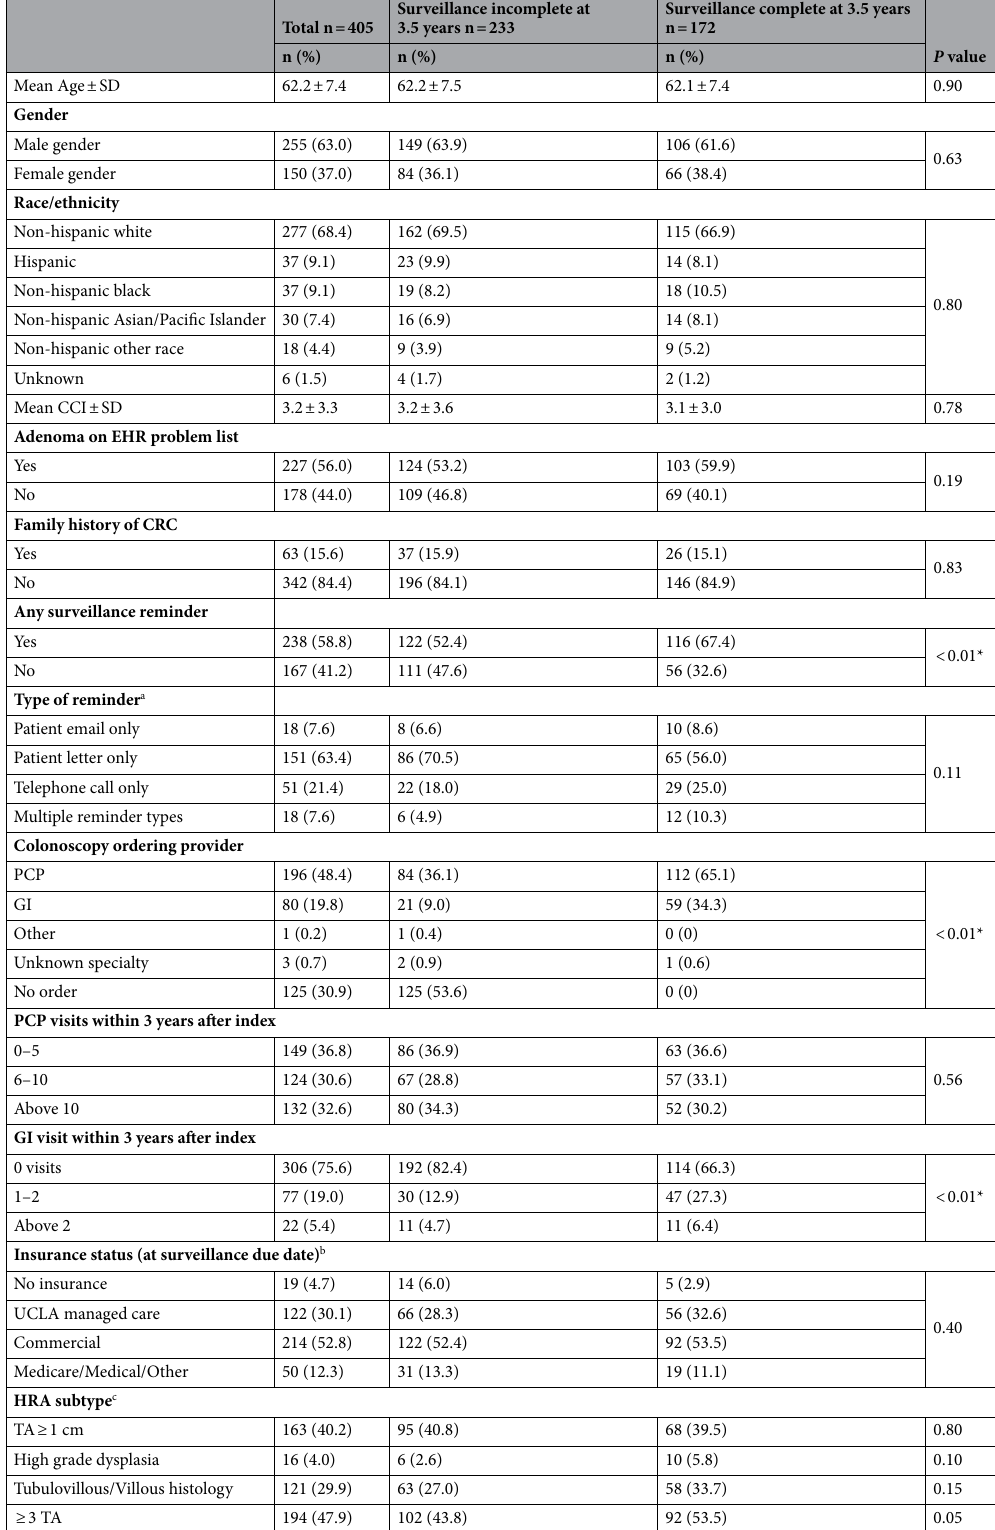
Table 1. Demographic and clinical characteristics for the total patient cohort, overall and by surveillance status at 3.5 years. CCI Charlson Comorbidity Index; CRC colorectal cancer; EHR electronic health record; GI gastroenterologist; HRA high risk adenoma; PCP primary care physician; SD standard deviation; TA tubular adenoma. a Comparing only among those receiving a reminder; n = 238. b Insurance groupings are mutually exclusive. c HRA subtypes are not mutually exclusive. *Denotes statistical significance at the P < 0.05 level. % are column percents unless otherwise